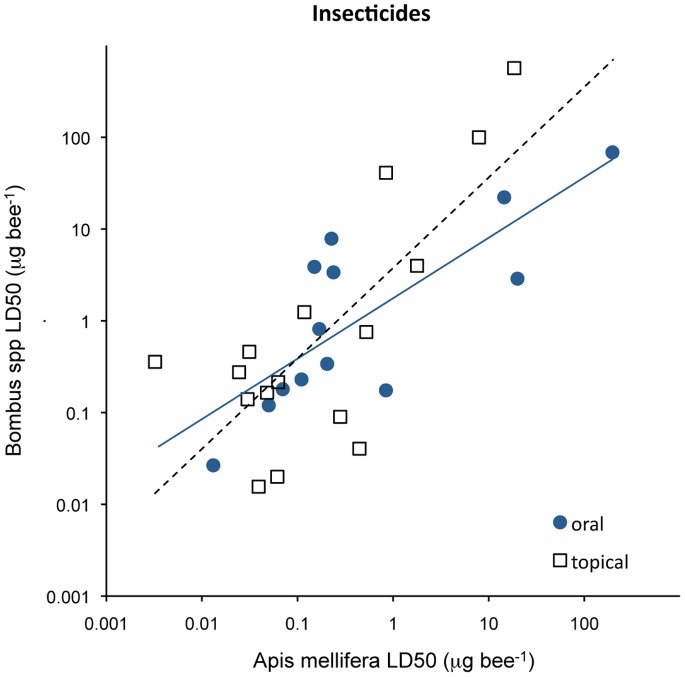
Comparison of the sensitivity of honey bees (Apis mellifera) and bumble bees (Bombus spp.) to 29 insecticides, as expressed by their contact or oral LD50s (μg bee−1).Susceptibility of both species by oral exposure is similar (line, slope = 0.34, p<0.001), whereas on average bumble bees are 7 times less sensitive than honey bees by contact exposure, after correcting for weight (stippled line, slope = 28.3, p<0.001).